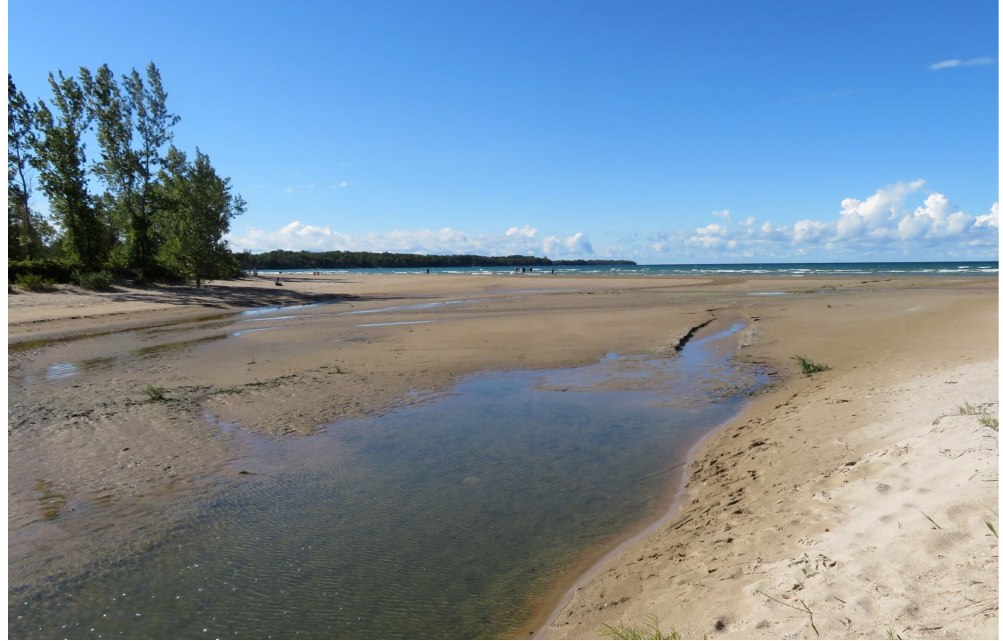
Figure 14. The low water level at Outlet River and Beach (Photo by: John A. Brebner, 2021 @friend- sofsandbanks on